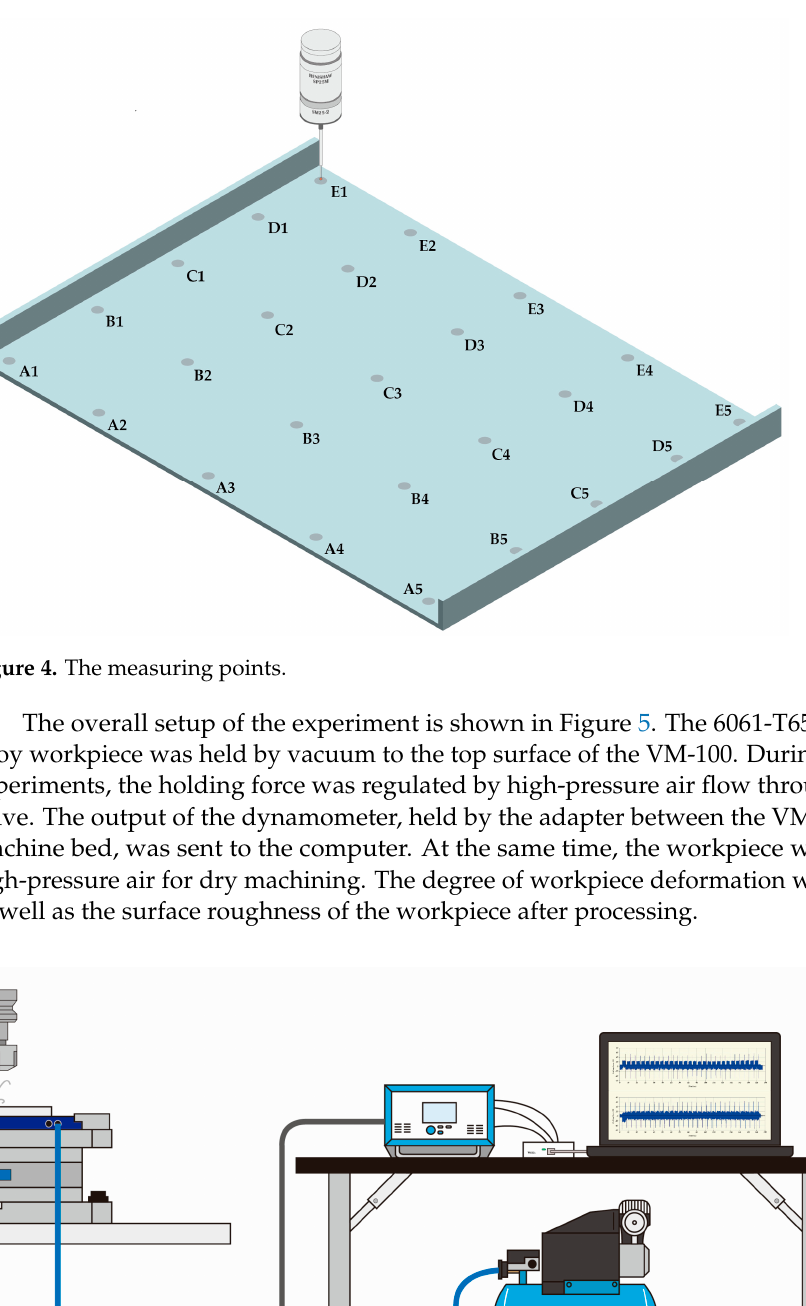
Figure 5. Schematic diagram of the experimental machining setup.